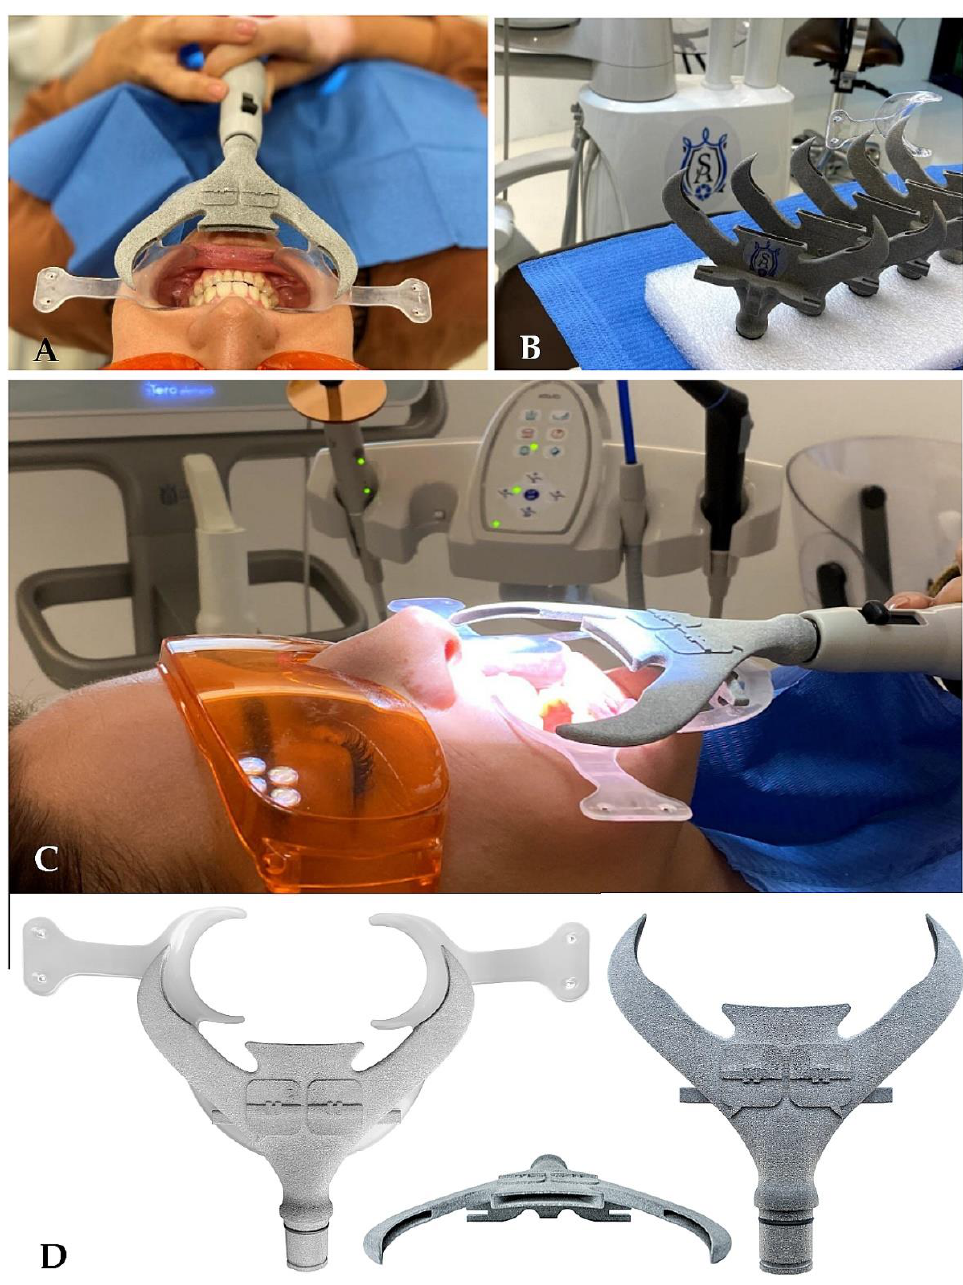
Figure 3. 3D printed aerosol interception device. ( A ) Frontal view of 3D printed aerosol suction attached to surgical suction system and oral retractor. ( B ) With 3D printing, each office can be supported with adequate quantities. ( C ) Lateral view of “SUR - FACE” attached to conventional retractor. ( D ) View of “SUR - FACE” with and without cheek retractor and view of three suction openings.